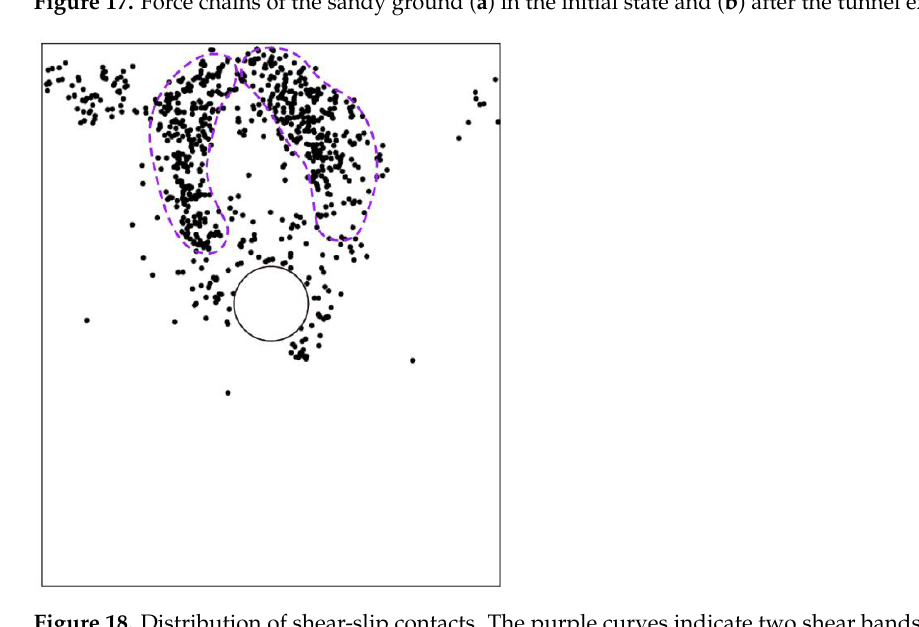
Figure 17. Force chains of the sandy ground ( a ) in the initial state and ( b ) after the tunnel excavation.